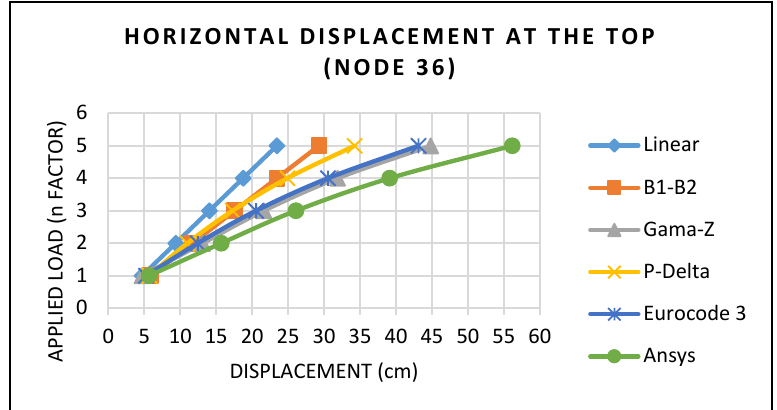
Figure 8 – Top floor displacement at node 36. Source: Authors (2020)